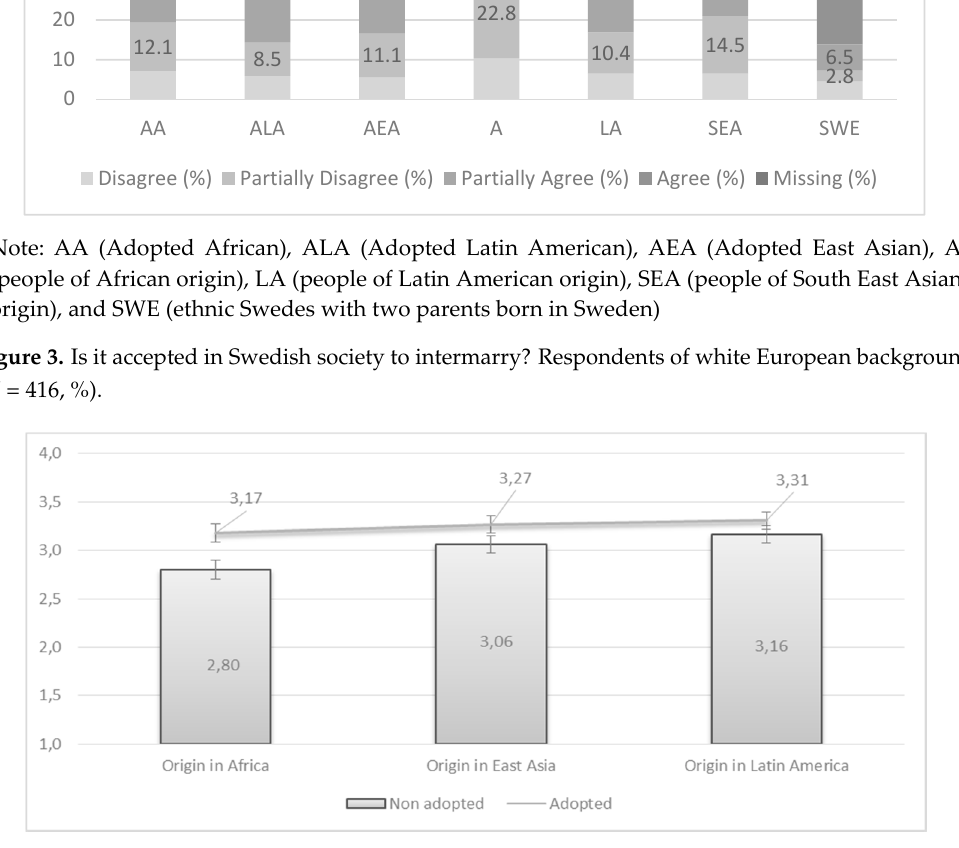
Figure 4. Social acceptance of interracial marriages: Comparison of white European respondents’ attitudes towards non-white adoptees and non-white migrants.